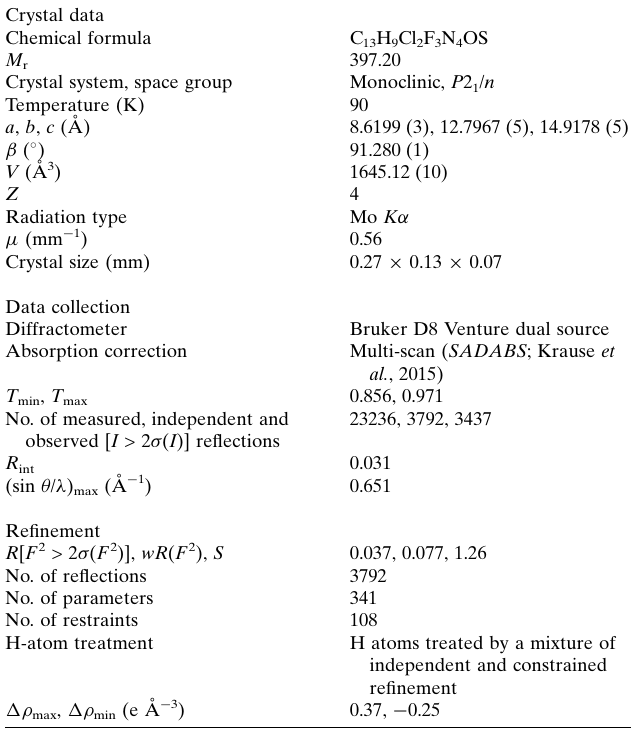
Crystal data Chemical